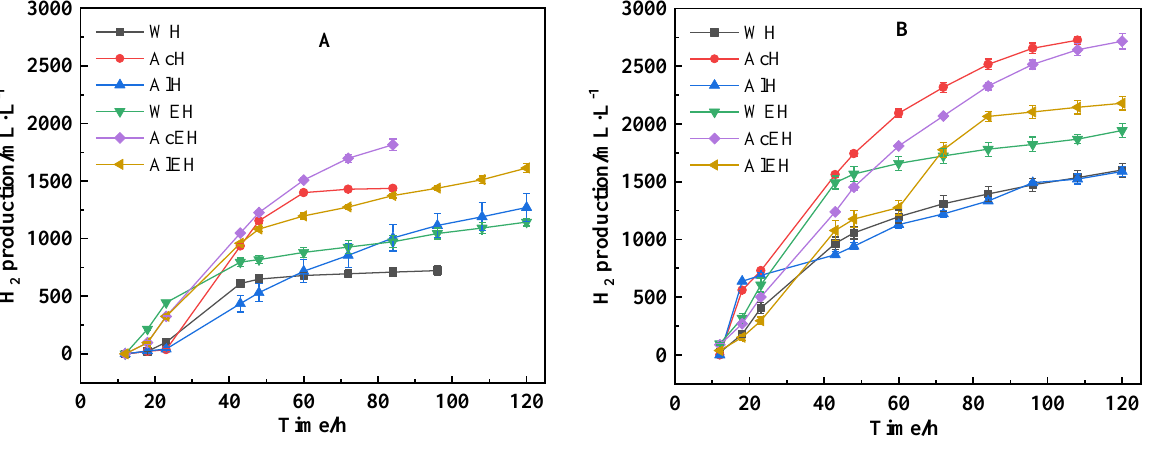
CS and SS hydrolysates were used as substrates for PFHP. Figure 5 depicts the cu- mulative PFHP time curves with hydrolysates. The cumulative hydrogen production from CS was highest for AcEH at 1815.45 ± 49.41 mL·L −1 and lowest for WH at 723.15 ± 41.34 mL·L −1 . For SS, the cumulative hydrogen production of AcH was the highest at 2726.10 ± 33.49 mL·L −1 , followed by AcEH at 2716.25 ± 65.77 mL·L −1 , and AlH was the low- est at 1589.46 ± 41.86 mL·L −1 .